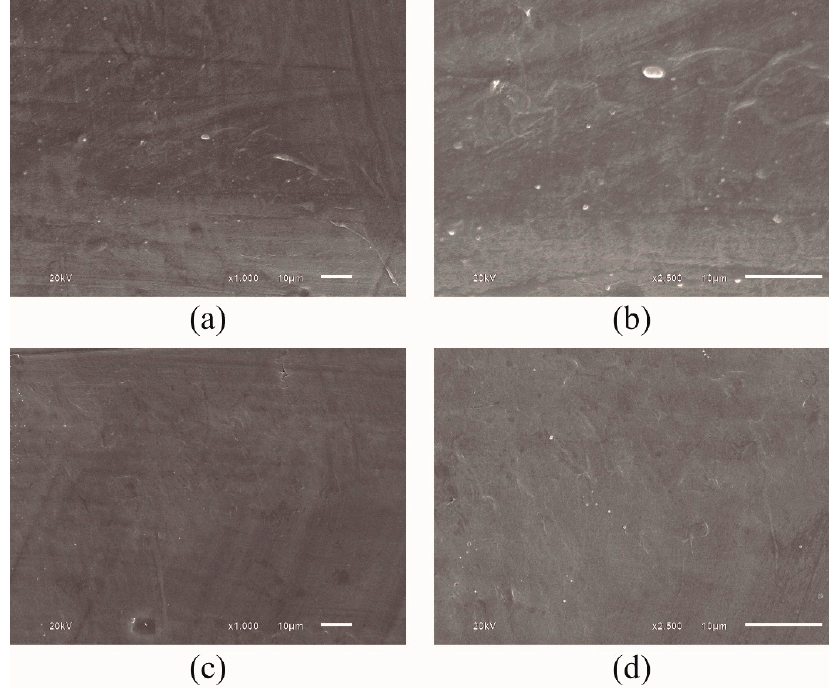
Figure 3. PTFE samples under different magnification. ( a ) PTFE reference with magnification of × 1000; and ( b ) PTFE reference with magnification of × 2500 times; ( c ) PTFE sample immersed in oil for 90 days, with magnification of × 1000; and ( d ) PTFE sample immersed in oil for 90 days, with magnification of × 2500